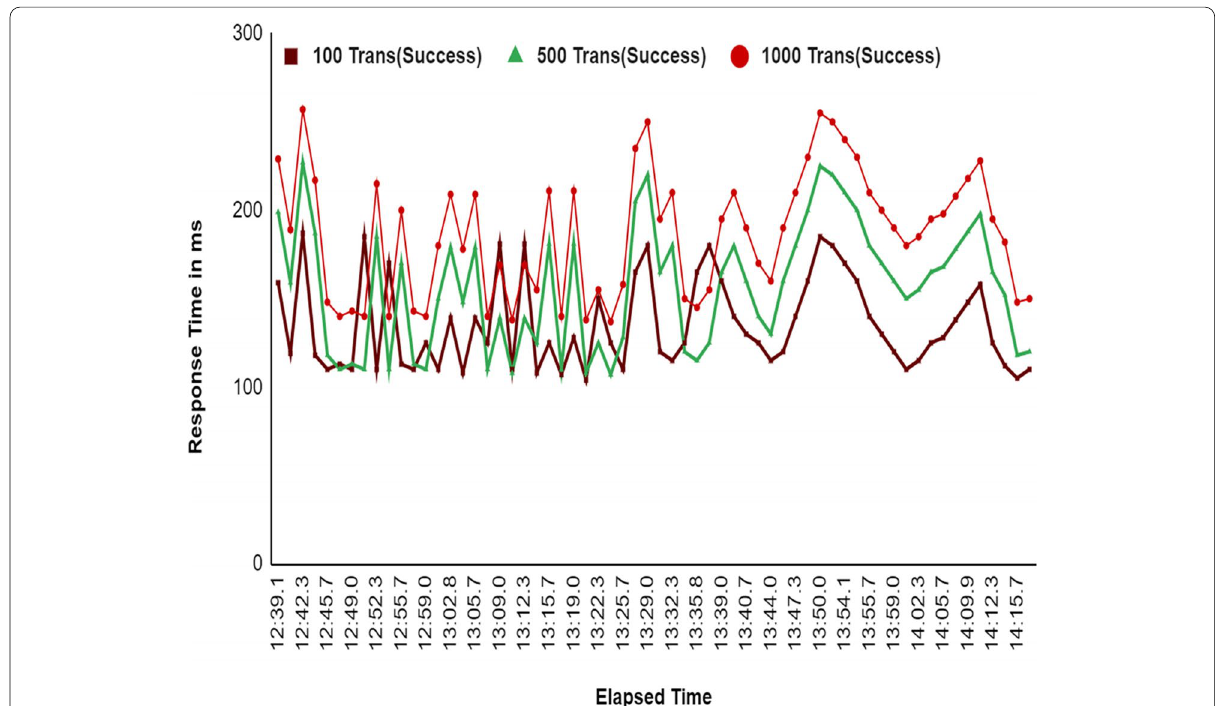
Fig. 10 Comparative Analysis of Response Time with Three Different Sets of Transaction